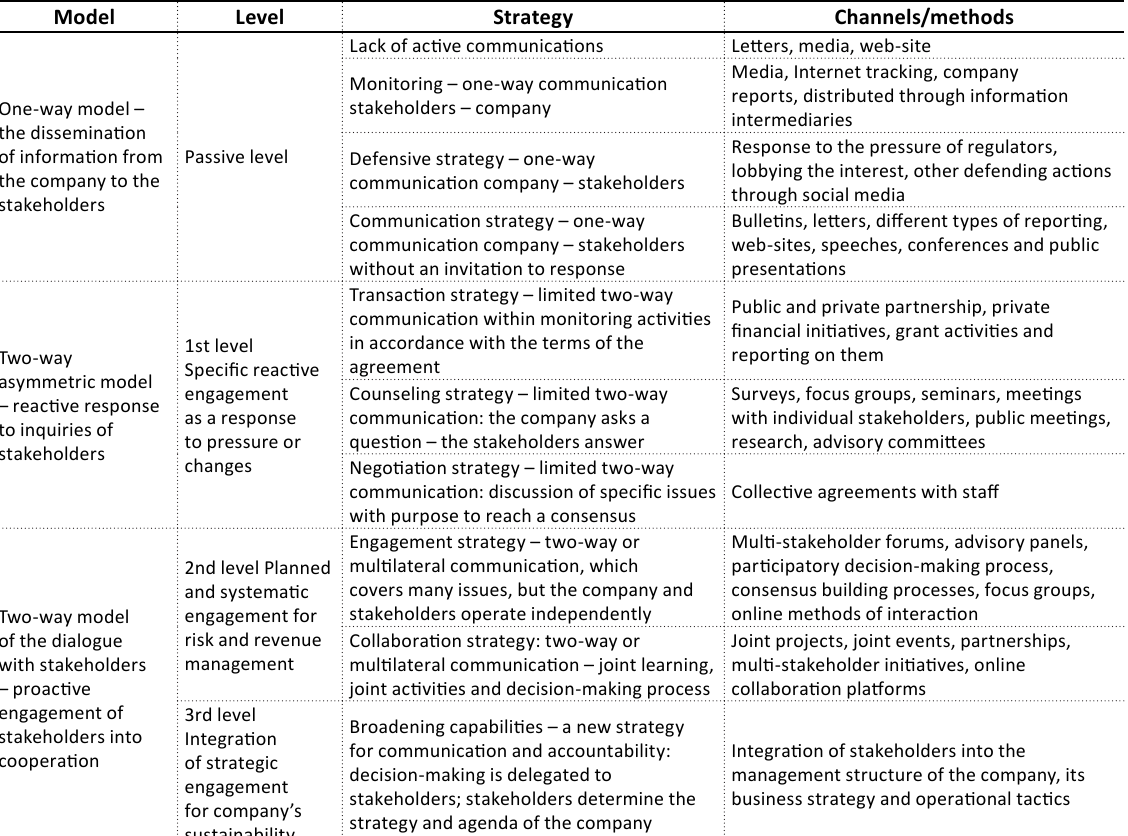
Source: Compiled by authors based on Accountability